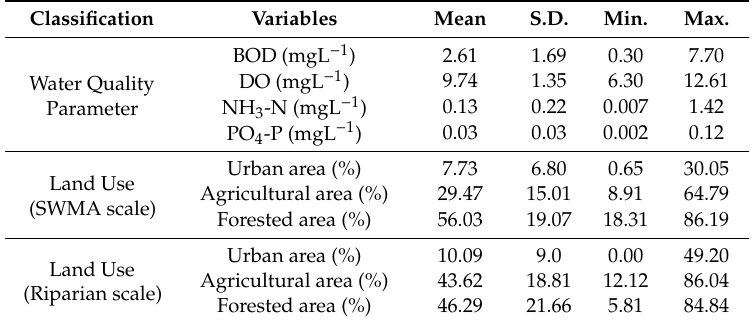
Table 1. Descriptive statistics of measured water quality parameters and percentage of land use types at two di ff erent scales. SWMA, sub-watershed management